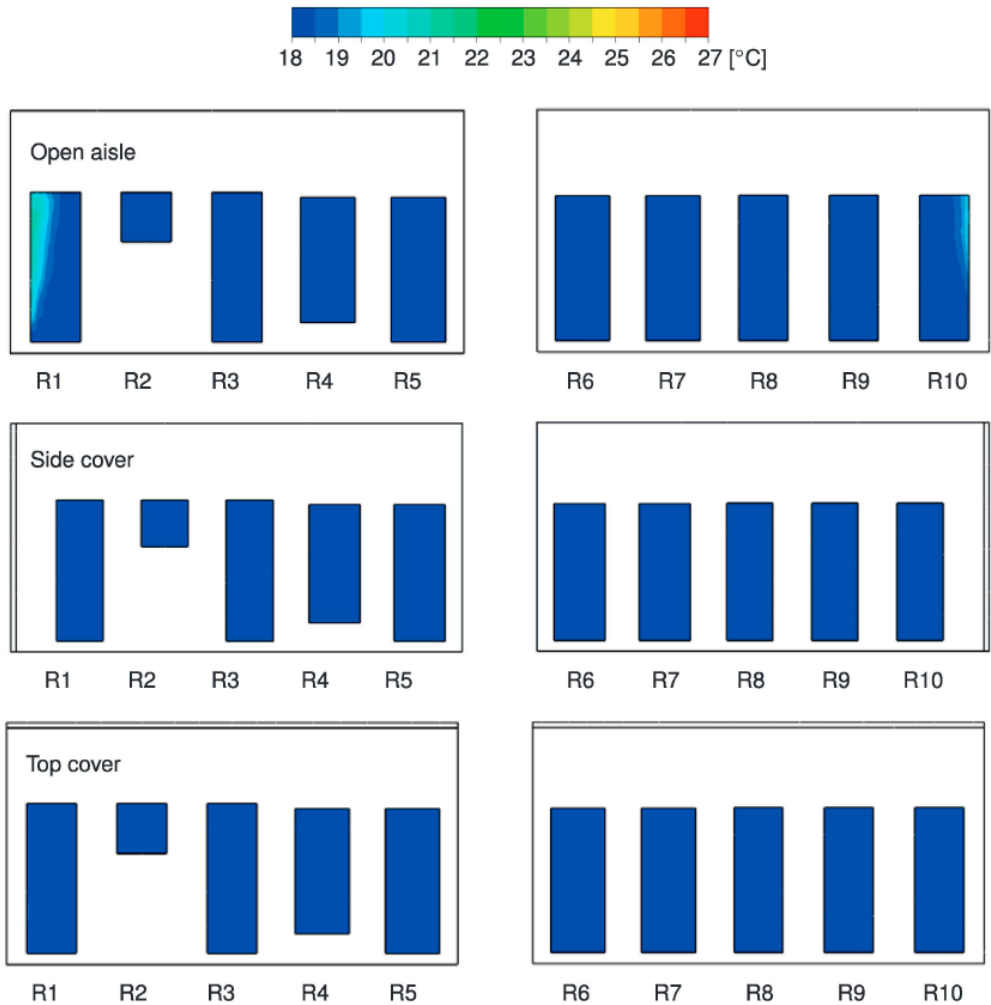
Figure 8. Rack intake temperatures for the raised floor configurations.